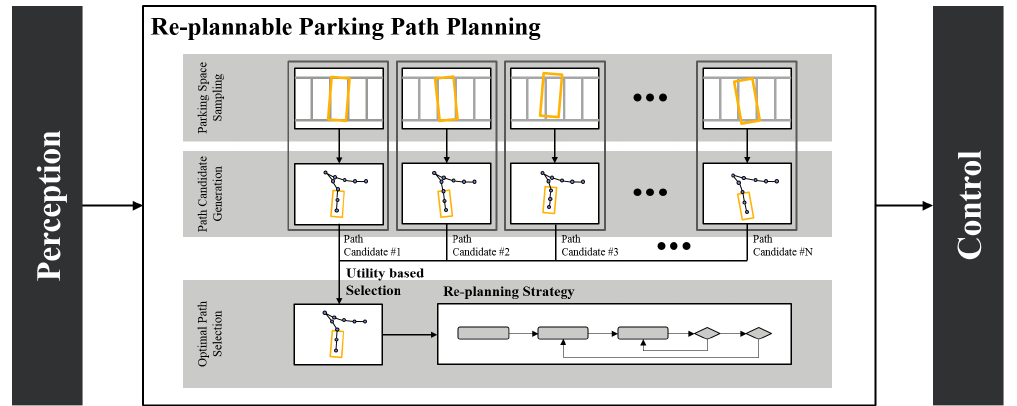
Figure 2. The overall architecture of re-plannable parking path planning: parking space sampling, path candidate generation, and optimal path